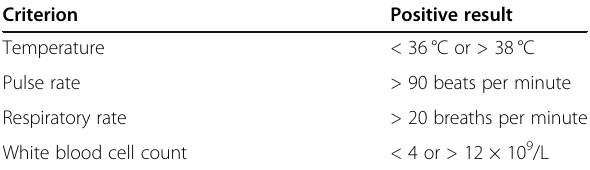
Table 1 Systemic inflammatory response syndrome criteria